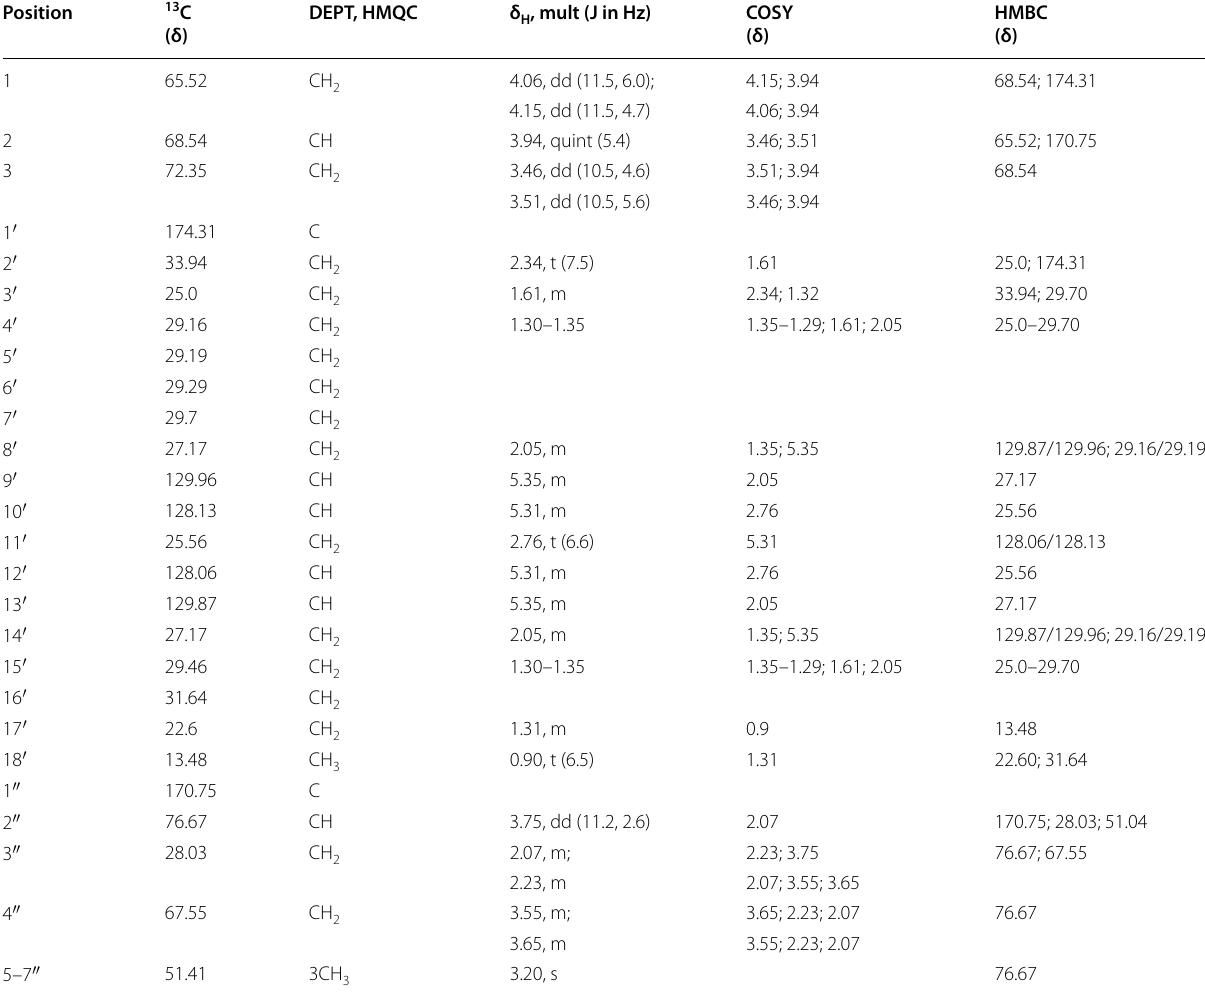
Table 5 1D and 2D NMR spectral data (δ in ppm) of compound 11